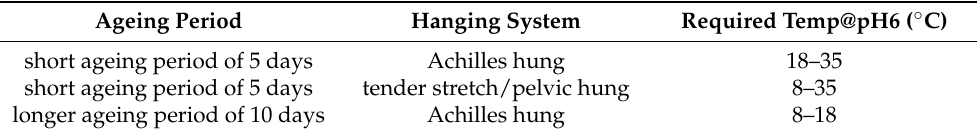
Table 2. MLA recommendations for aging time depending on hanging method and use of ES on lambs. Adapted from